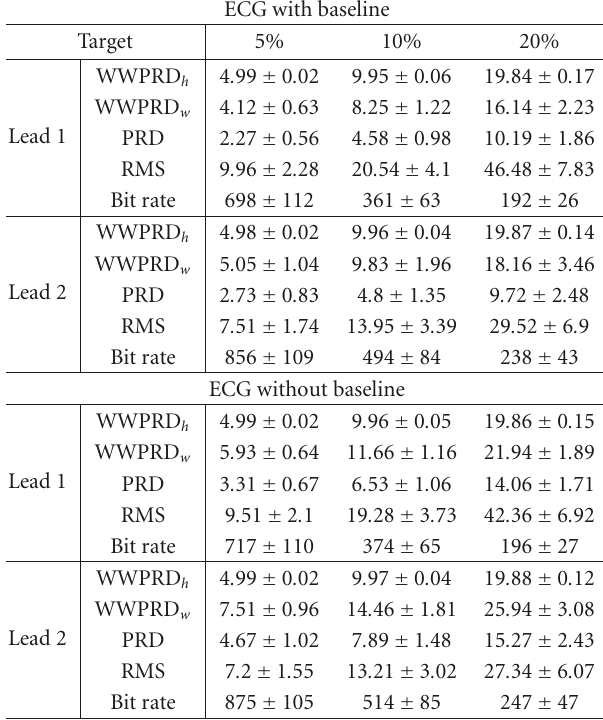
Table 1: Results when guaranteeing WWPRD h in MIT-BIH ar- rhythmia. (WWPRD h , WWPRD w , and PRD expressed in %, RMS expressed in μV and bit rate in